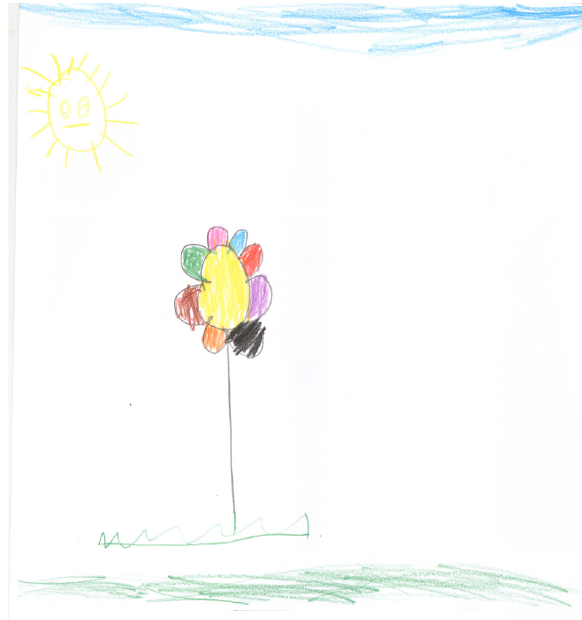
Figure A3. A spontaneous drawing depicted by a 5-year-old child.